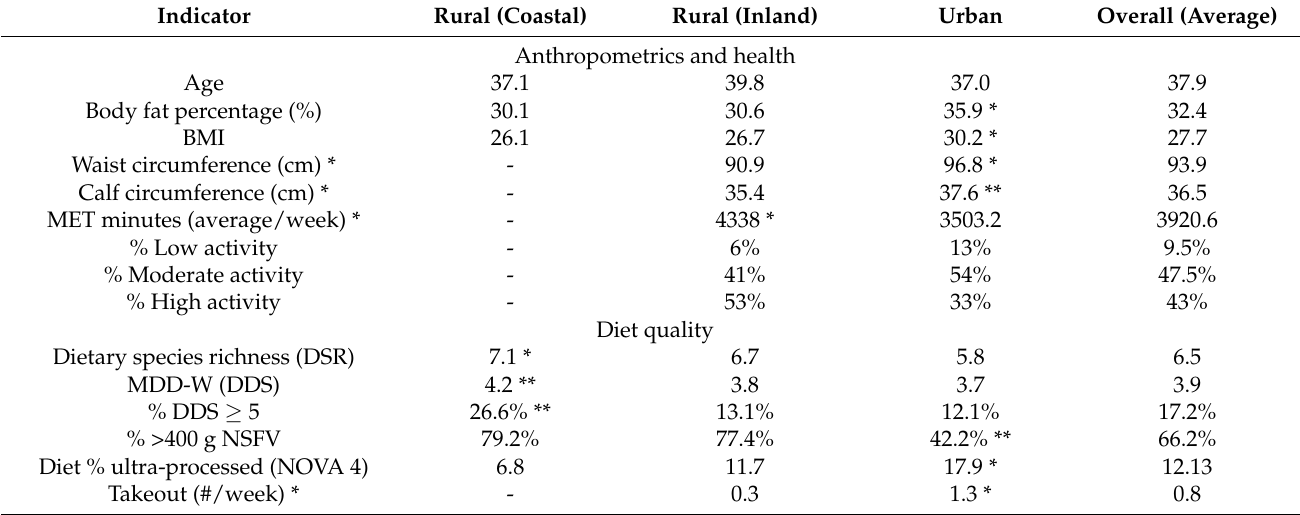
Table 2. Mean anthropometric, health, and diet quality indicators across rural coastal, rural inland, and urban Solomon Island populations ( n =